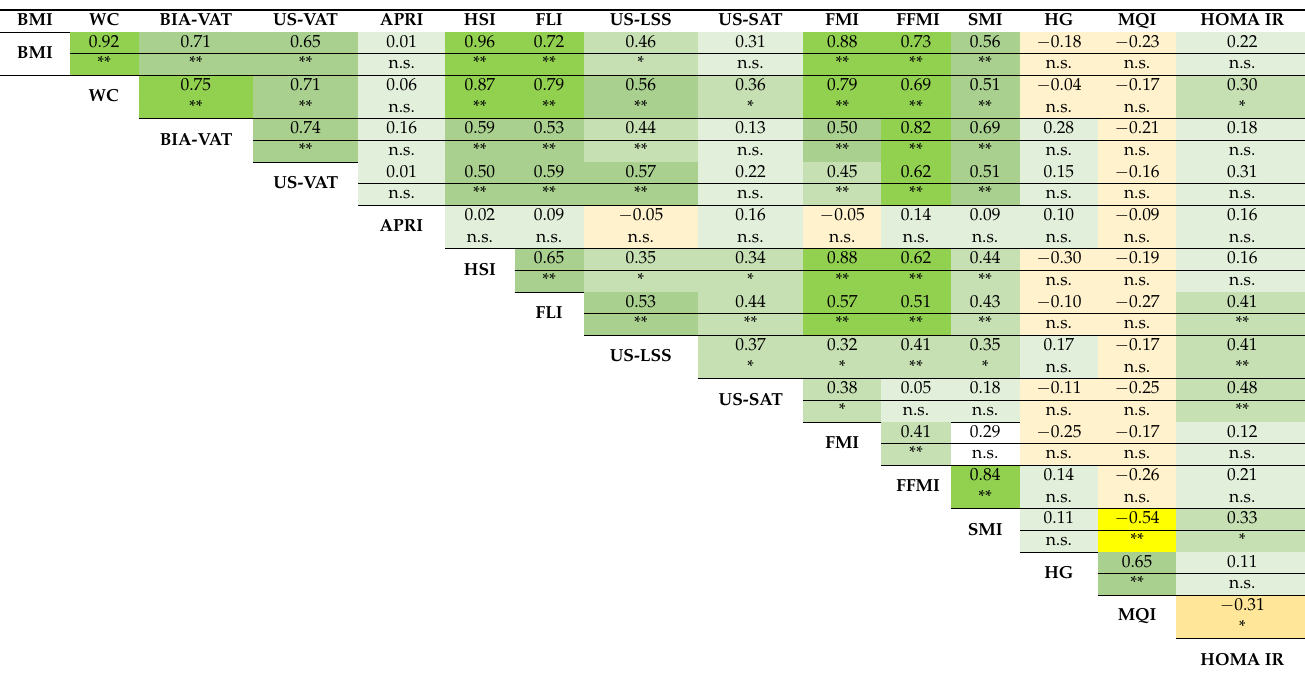
Figure 3. Baseline distribution of NAFLD severity according to a semiquantitative US-score in the study population. Abbreviation: NAFLD = non-alcoholic fatty liver disease; US = ultrasonographic. To assess the internal consistency of measurements, some statistical correlations were calculated at baseline (Table 3). In particular, both VAT evaluated by BIA (BIA-VAT) and FMI were positively correlated with HSI, FLI, US-VAT, and LSS. In addition, the HOMA-IR index was found to correlate positively with FLI and LSS, and negatively with MQI (Table 3). Of note, our 12-point LSS correlated significantly with the semiquantitative 4-point score (r = 0.76; p < 0.001). Table 3. Correlations between the examined variables.